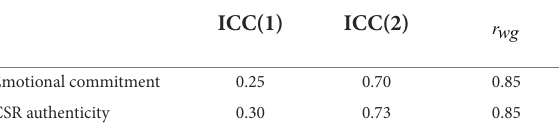
TABLE 6 Within-group agreement and ICC value of the dependent variable.